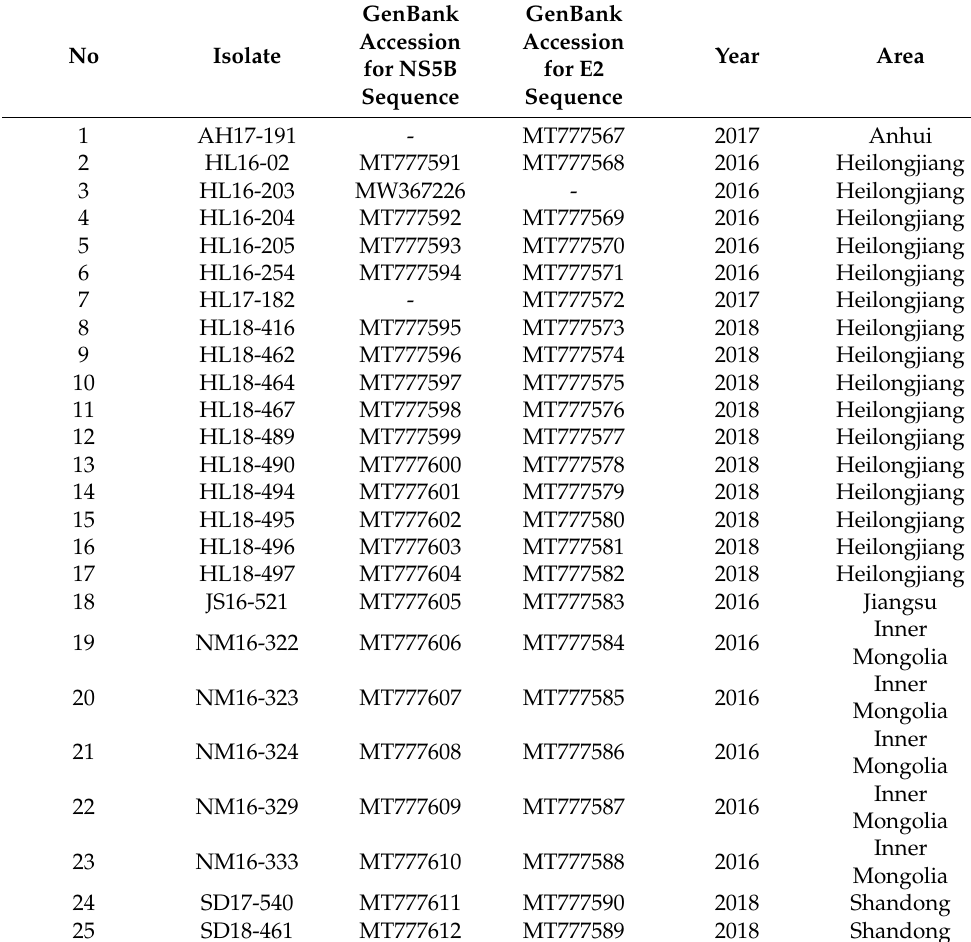
(Table 1) along with reference sequences downloaded from GenBank (Table S2) were used for phylogenetic analysis. Table 1. New isolated strains of CSFV from China in this study based on NS5B and E2 genes.